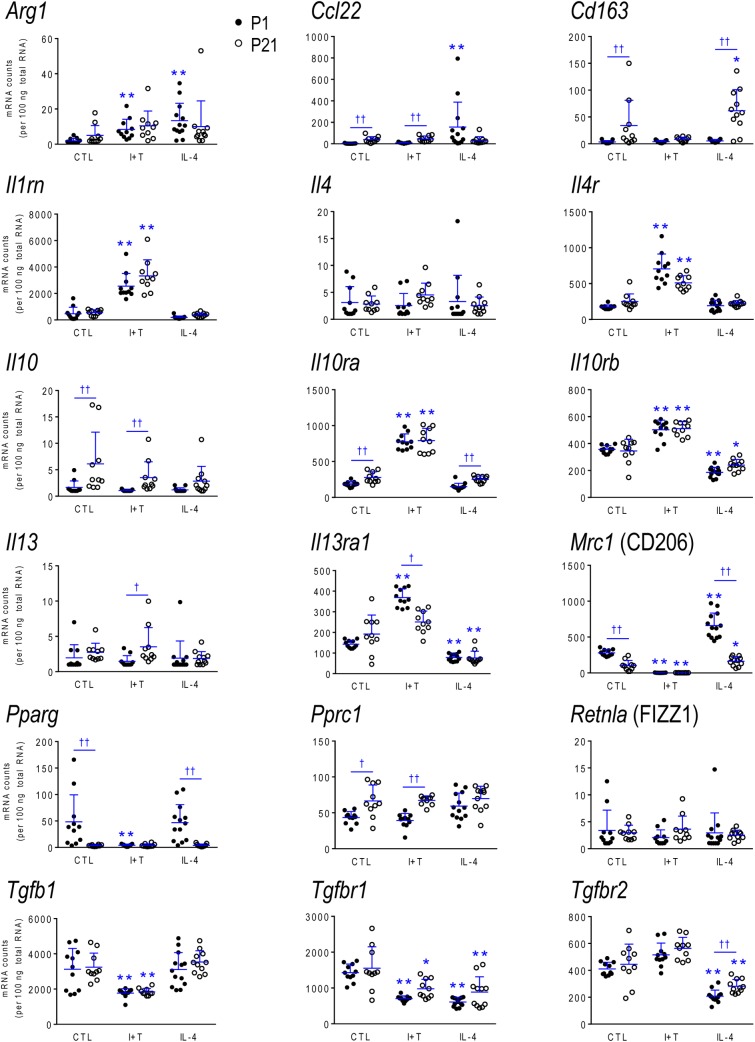
Age-dependent transcriptional responses: Anti-inflammatory mediators. As in Figure 2, microglia were stimulated for 24 h with IFNγ and TNFα (I+T) or IL-4. The scatterplots show individual mRNA values (normalized; see Materials and Methods) and the mean ± SD. Differences shown are with respect to control microglia (∗) and between P1 and P21 cells (†). One symbol of either type indicates p < 0.05; two symbols, p < 0.01.